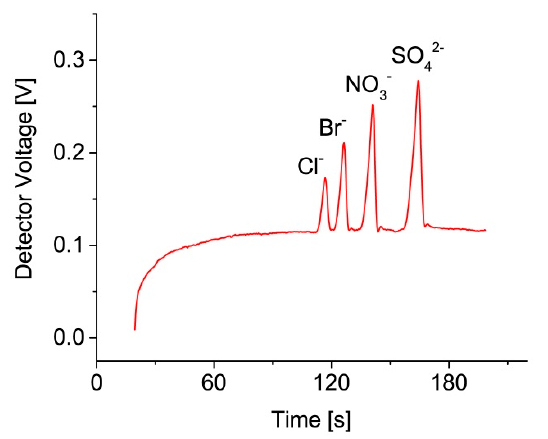
Figure 3. An electropherogram with baseline separation of a sample containing the ions Cl − , Br − , NO 3 − and SO 4 2 −